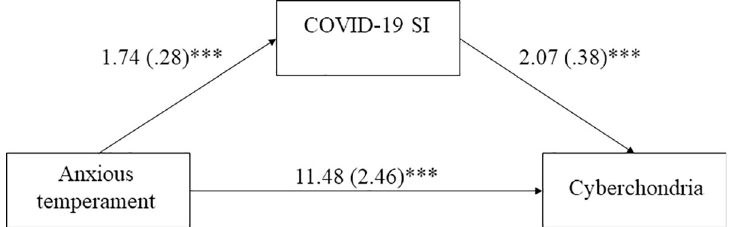
Fig 1. The mediating effect of COVID-19 SI in relationship between anxious temperament and cyberchondria. Unstandardised coefficients are reported, with standard errors in parentheses. ��� p < .001.